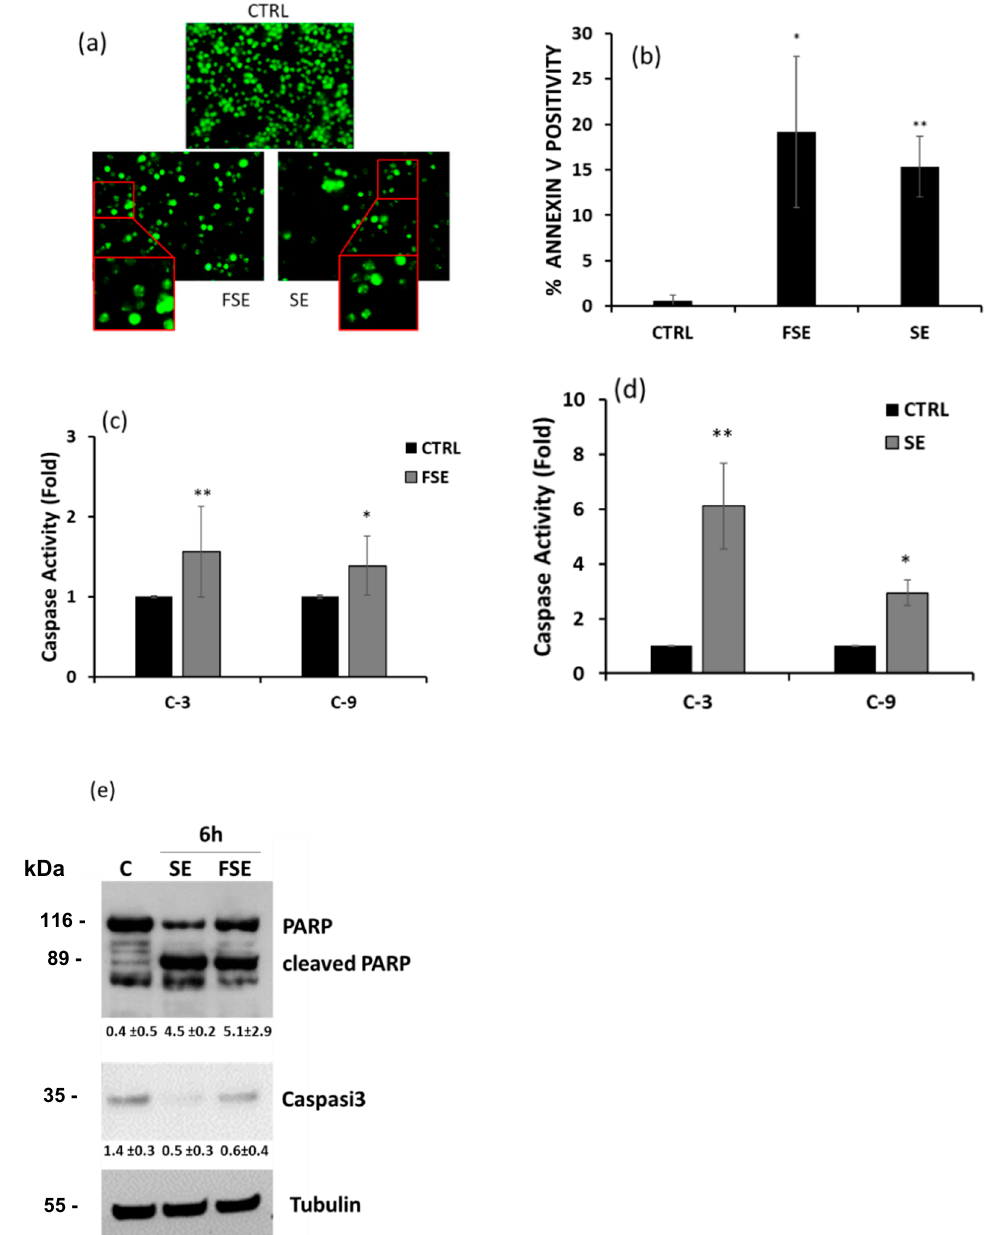
Figure 5. FSE induces apoptosis in HL-60 cells. ( a ) Representative images of cells untreated (top) and treated with FSE and SE (bottom) stained with CyQuant. Cells were visualized using fluorescent microscopy and photographed in FITC filter with 200 × magnification. ( b ) PS externalization was evaluated by treating cells for 15 h and measuring the percent of Annexin-V positivity using cytofluorimetry. The proteolytic activity of caspase-3 and -9 (nmol AFC/min/ μ g protein) induced by ( c ) FSE and ( d ) SE at 25 μ M eqGA was measured after 6 h of treatment. Bar graphs represent means ± SD derived from three separate experiments. In panel ( e ) the immunoblots showing PARP cleavage and the reduction in pro-Caspase-3 in HL-60 cells are reported. Numbers between panels indicate the densitometric analysis ± SD of three independent experiments. Symbols indicate significance: p < 0.05 (*) and p < 0.005 (**) respect to CTRL.